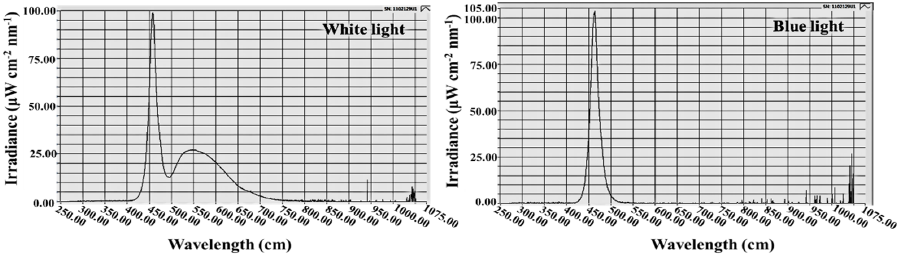
Figure 1. The spectral distribution of lights used in this experiment: The daily W light (~400–750 nm) provided by white LEDs and B light (450 nm) from blue LEDs used as the supplementary and night ‐ interrupting light.